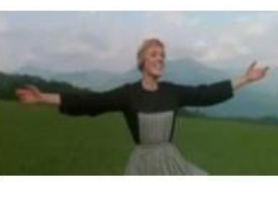
Figure 3. The Sound of